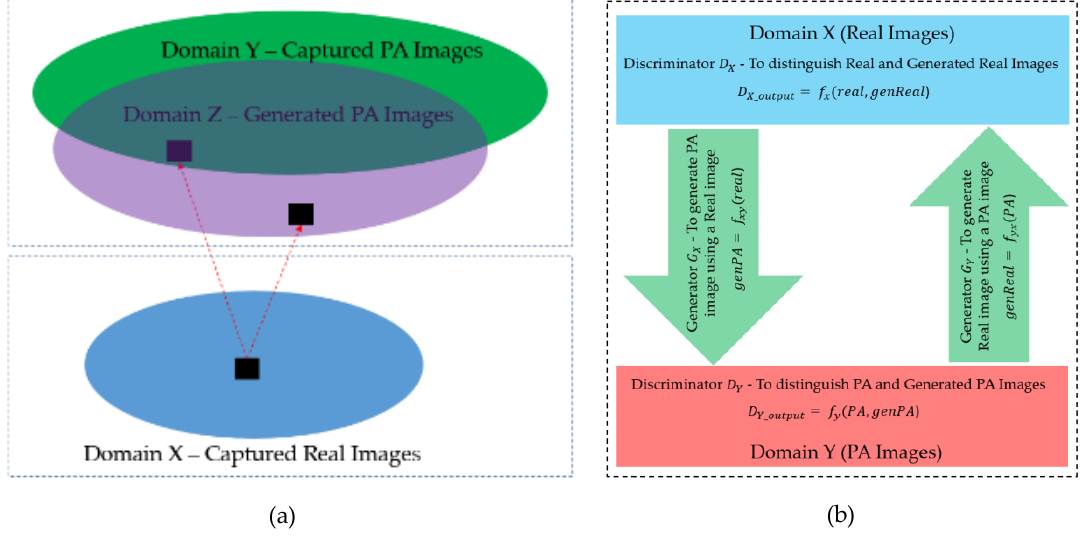
Figure 3. Overview of our deep-learning-based image generation network: ( a ) Demonstration of the distribution of real and PA images; ( b ) Overview of our network structure for PA image generation. In this figure, the real and PA indicate the captured real or presentation attack images; genReal and genPA indicate the generated real and generated presentation attack images using generator networks and the input real and PA images; 𝑓 𝑥 ,𝑓 𝑦 ,𝑓 𝑥𝑦 ,𝑎𝑛𝑑 𝑓 𝑦𝑥 indicates the relation function models by discriminator ( 𝐷 𝑋 , 𝐷 𝑌 ) and generators ( 𝐺 𝑋 , 𝐺 𝑌 ), respectively.